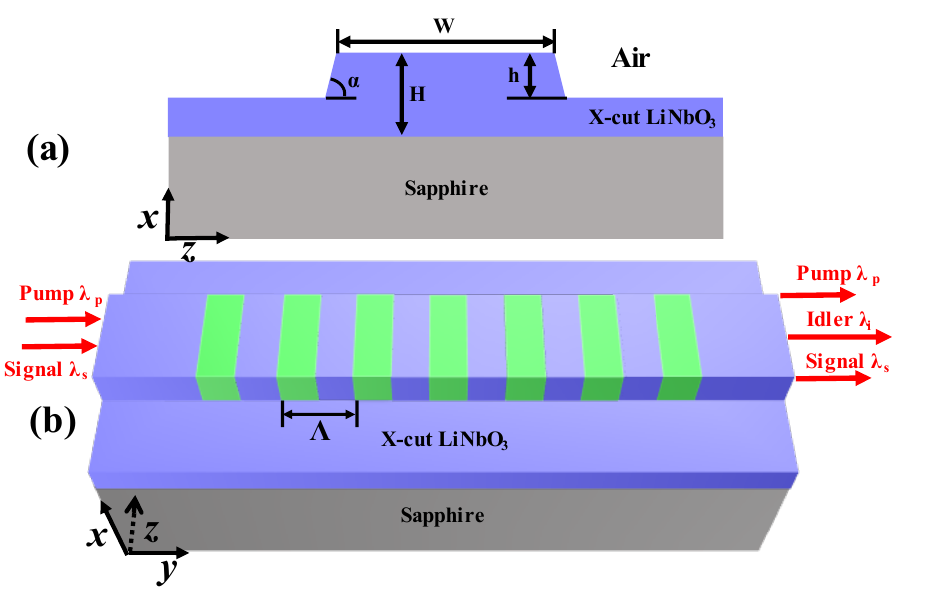
Figure 1. Structural schematic of mid-IR QPM-DFG based on periodically poled TF-LN-on-sapphire rib-type waveguide: ( a ) cross-section and ( b ) 3D view.